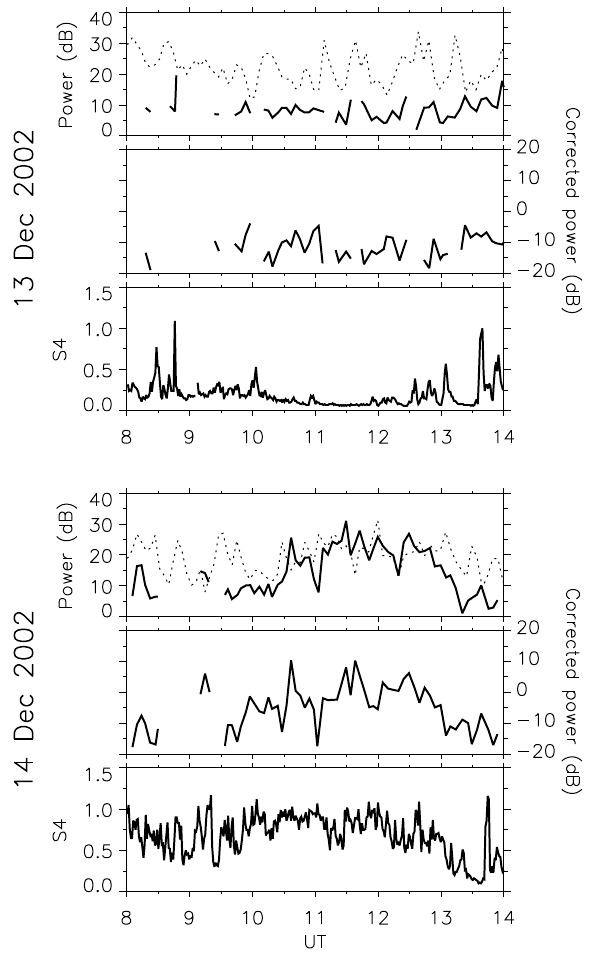
Fig. 4. A comparison of radar backscatter and scintillation mea- surements from the intersection point, for the 13 (top panels) and 14 (bottom panels) December 2002. In each case: (top panel) iono- spheric backscatter power (solid curve) and ground scatter power from ground reflection point (dotted curve); (middle panel) cor- rected power (see text); (bottom panel) S4 scintillation